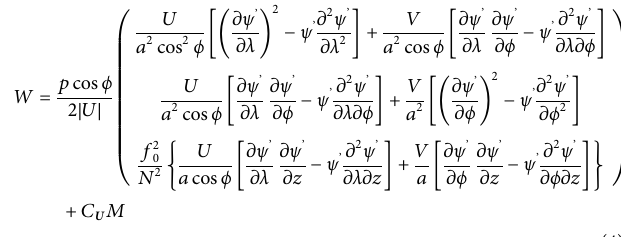
Frontiers in Earth Science |